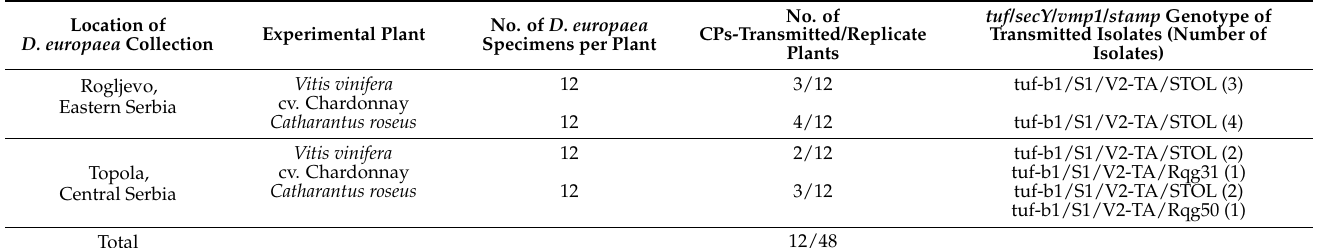
Table 3. Experimental transmission of ‘ Ca. P. solani’ to grapevine and Catharantus roseus by naturally infected Dictyophara europaea